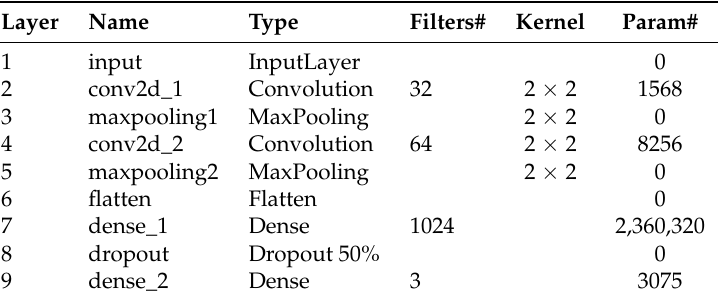
Table 3. Environmental impact model